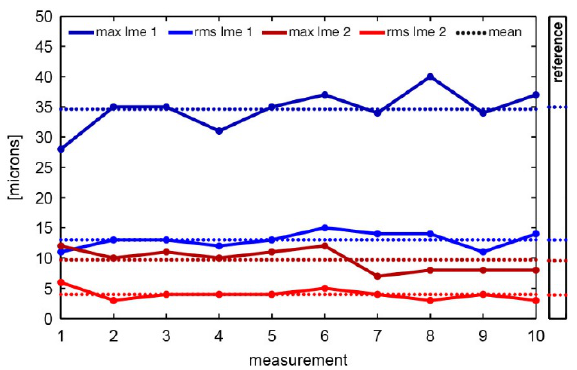
Figure 15. Quality characteristics (ellipse eccentricity)